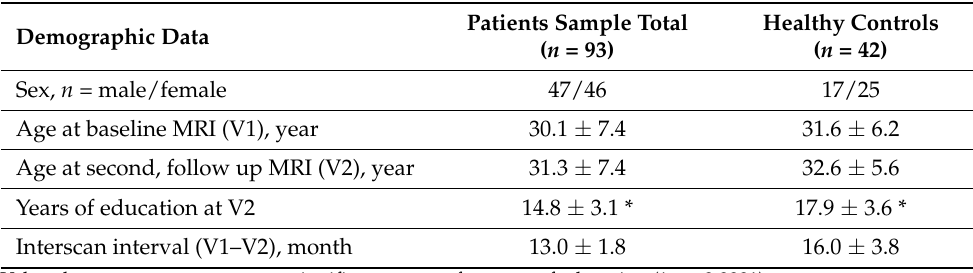
Table 1. Demographic Data of Schizophrenia Patients and Healthy Controls. The Data are Presented as Mean Values ± SD.